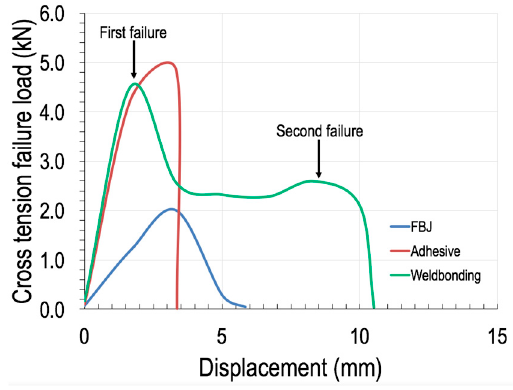
Figure 7. Representative load and displacement curves for cross-tension-tested FBJ, adhesive-bonded, and weld-bonded specimens. Table 6. Summary of cross-tension testing for each joining process.